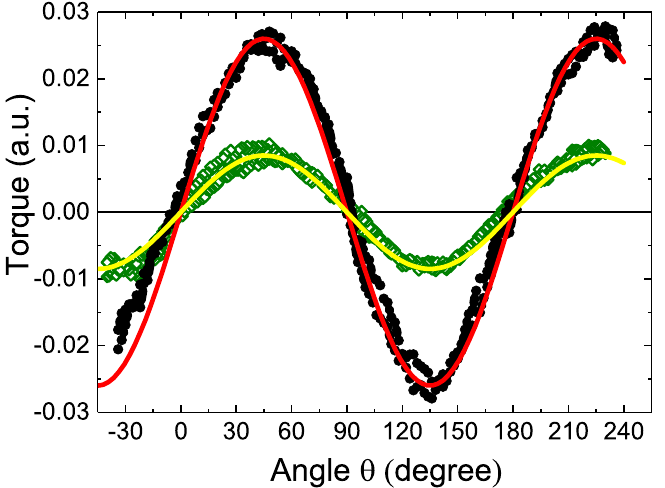
Figure 3. Torque signal of two natural graphite flakes vs. angle θ between the applied field H = 2 kOe and the c -axis of the graphite structure. The thicknesses of the samples were 1.2 µ m ( ♦ ) and 6.9 µ m ( • ). The lines are fits to a sin ( 2 θ ) function. The magnetic moment of the thinnest sample is of the order of ∼− 2 × 10 − 9